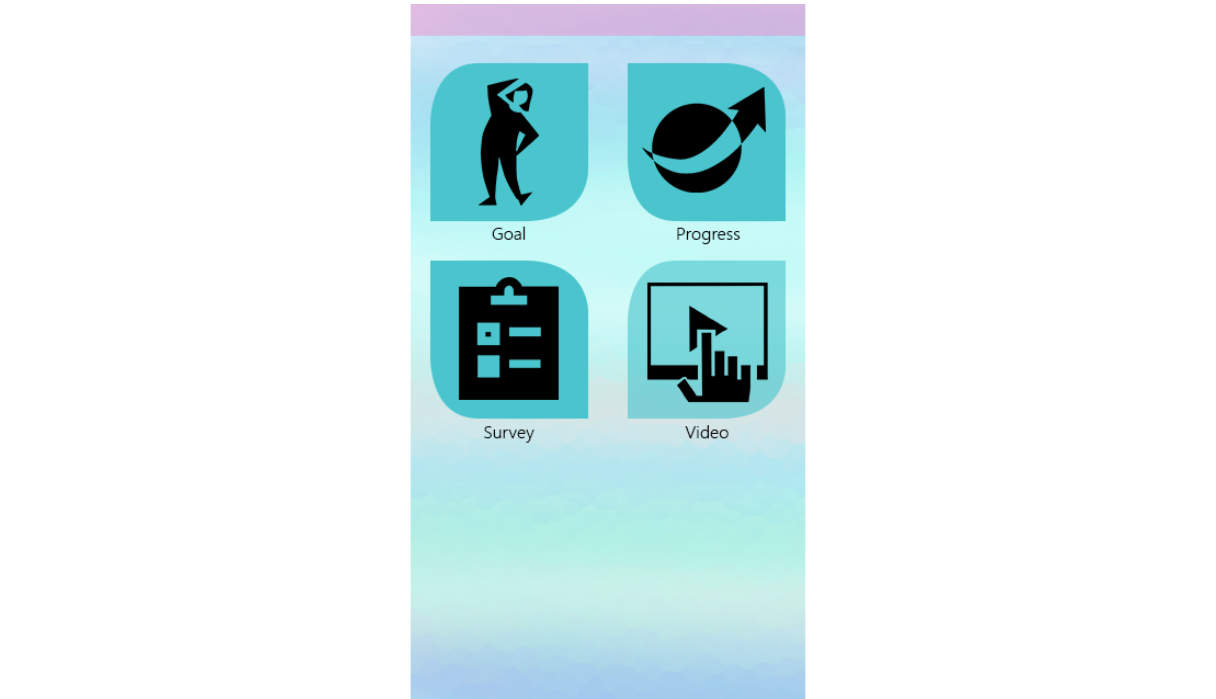
Figure 1. Main menu screen of HerBeat